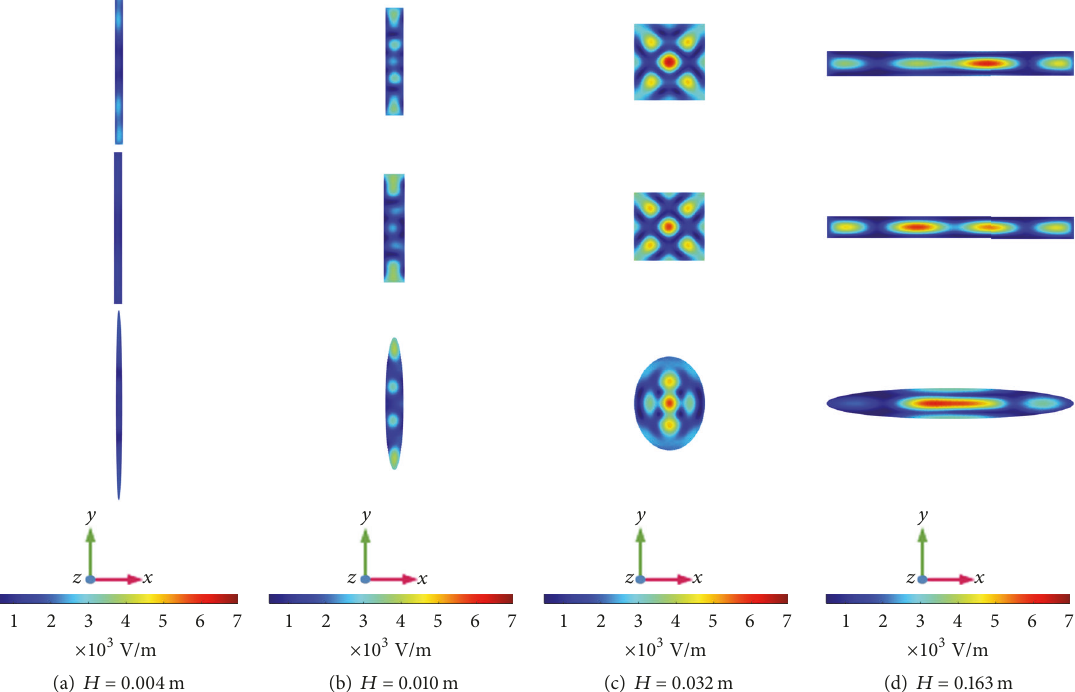
Figure 18: Electromagnetic field distribution on XY axial middle cross section in Orientation 1.